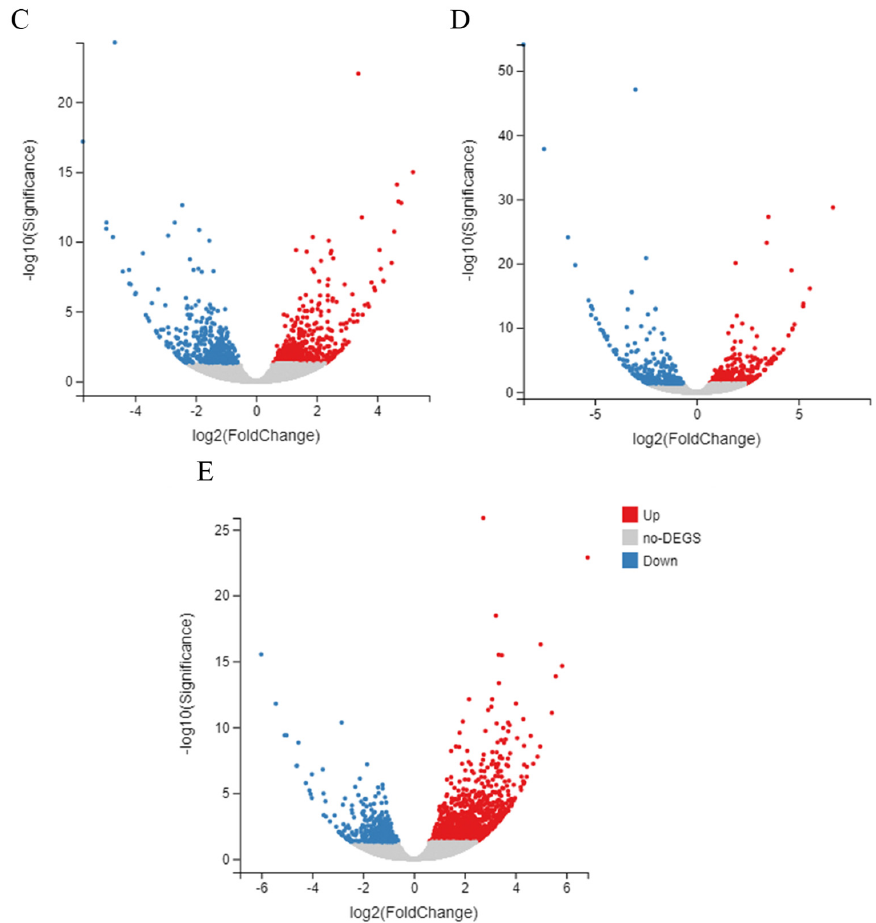
Figure 1. The volcano plots of differentially expressed genes (DEGs) between the N- ( A ), P- ( B ), K- ( C ), Ca- ( D ), and HZ- ( E ) treated and CK (control group) groups in Z. bungeanum seedlings. Significantly up-regulated unigenes are shown by red plots, whereas significantly down-regulated unigenes are represented by blue plots ( p ≤ 0.05). There is no substantial differential expression in the grey plots.